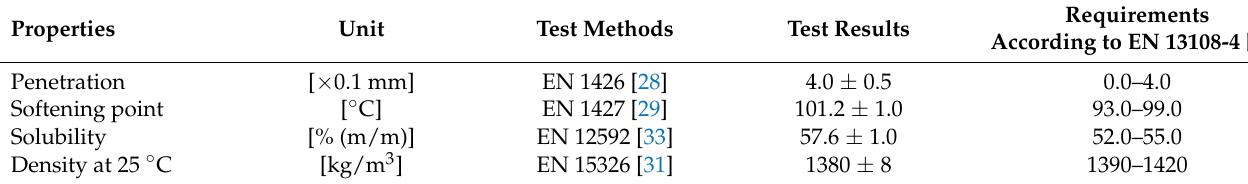
Table 2. Basic properties of